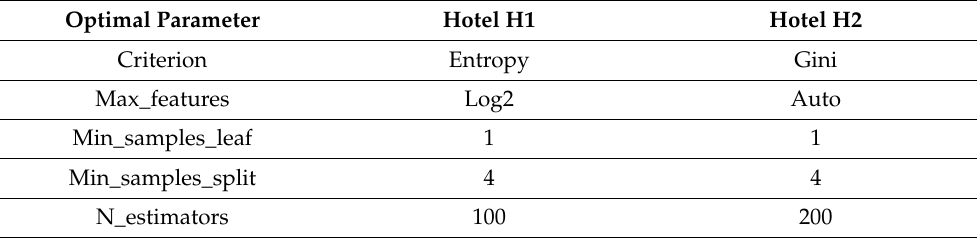
Table 2. Optimal parameters for random forest